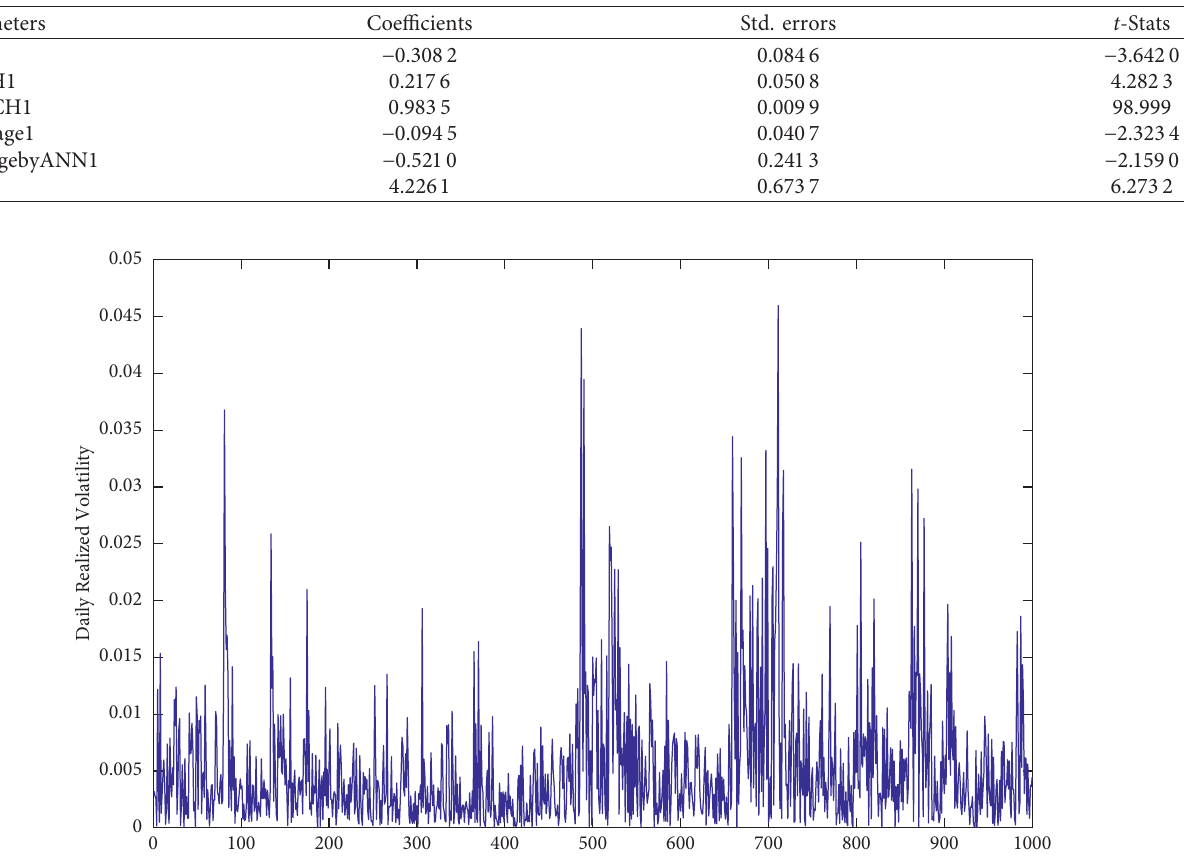
Figure 5: The histogram of the S&P 500 residual series. Table 3: The EGARCH-ANN (1,1,2,1) model fitted to the given S&P 500 data.